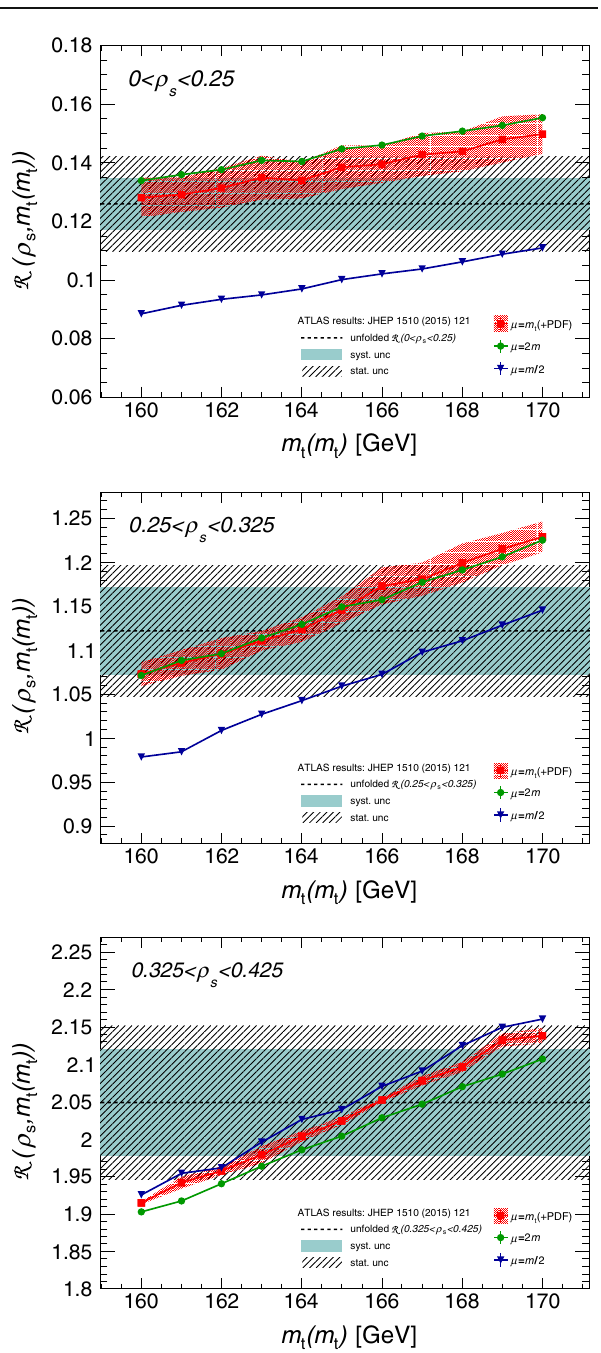
Fig. 2 R as defined in Eq. (3) as a function of m t ( m t ) for the ρ s < 0 . 425 intervals using the CT10 PDF set. The red squares show the results for the central scale μ = μ r = μ f = m t ( m t ) . The red band illustrates the impact of using the MSTW2008 or the NNPDF2.3 PDF set. The blue triangles (green dots) show the results for μ = m t ( m t )/ 2 ( μ = 2 m t ( m t ) ). For comparison we also illustrated as dashed line the measured result as reported in Ref. [15]. The bands show the systematic and statistical uncertainty respect to the central scale μ = m t ( m t ) (the upper value gives the shift for μ = 2 m t ( m t ) , the lower value gives the shift for μ = m t ( m t )/ 2). As for the t ¯ t + 1-jet cross